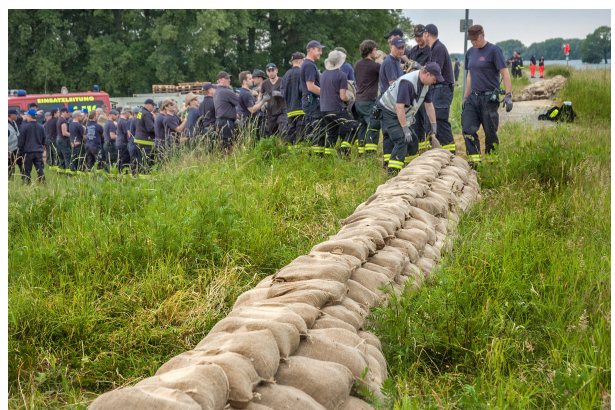
Figure 2. Firefighters during the Elbe flood in 2013, setting up a sandbag dam to raise a